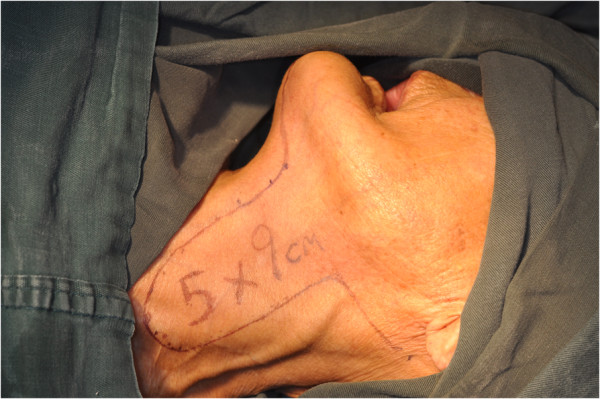
Design of the platysma myocutaneous flap.